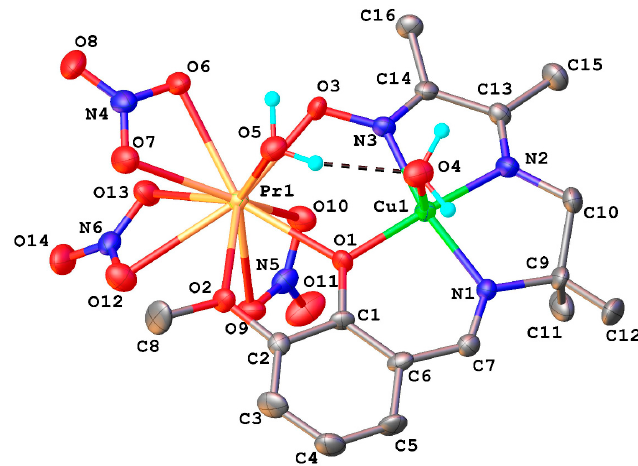
Figure 8. X-ray molecular structure of CuL 5 Pr(NO 3 ) 3 (H 2 O) 2 ( 8 ) with atom labelling scheme and thermal ellipsoids at 40% probability level. Non-relevant H-atoms are omitted. Selected bond lengths (Å) and angles (°). Cu1–N1 1.953(4), Cu1–N2 1.913(5), Cu1–N3 2.014(5), Cu1–O1 1.916(3), Cu1–O4